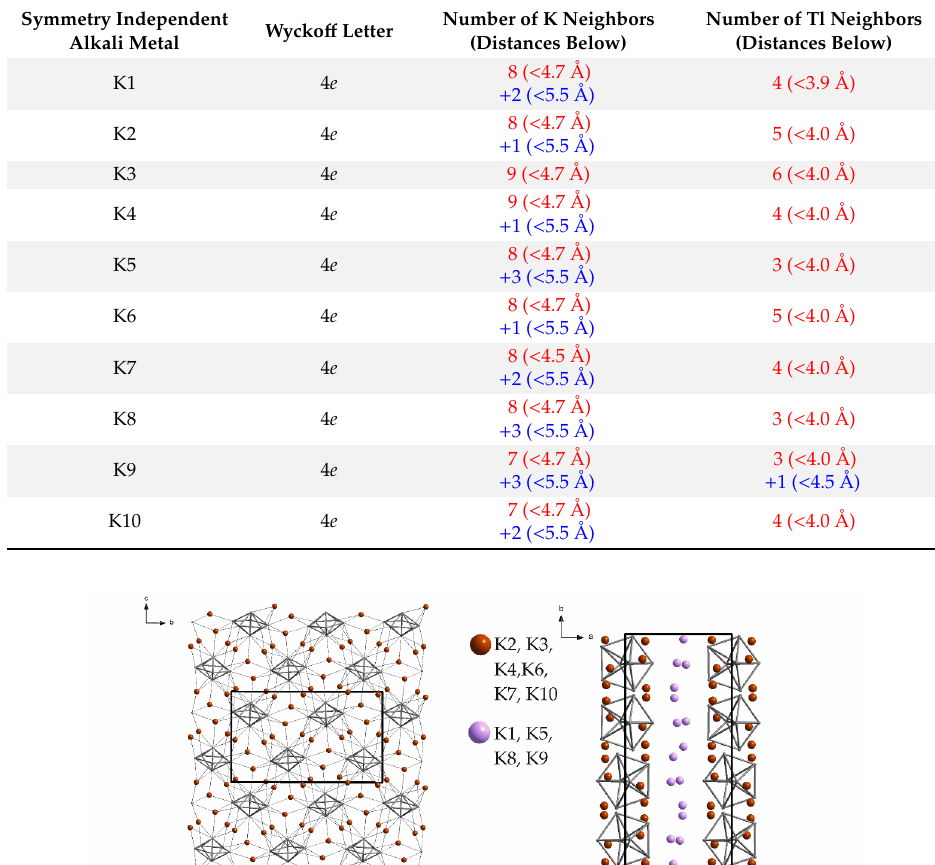
Table 14. Surrounding atoms of the symmetry inequivalent alkali metal positions in K 10 Tl 7 (space group P 2 1 / c ). The color-coding refers to the color of the contacts in Figure 12. Number of K Neighbors Symmetry Independent Wycko ff Letter Alkali Metal (Distances Below)